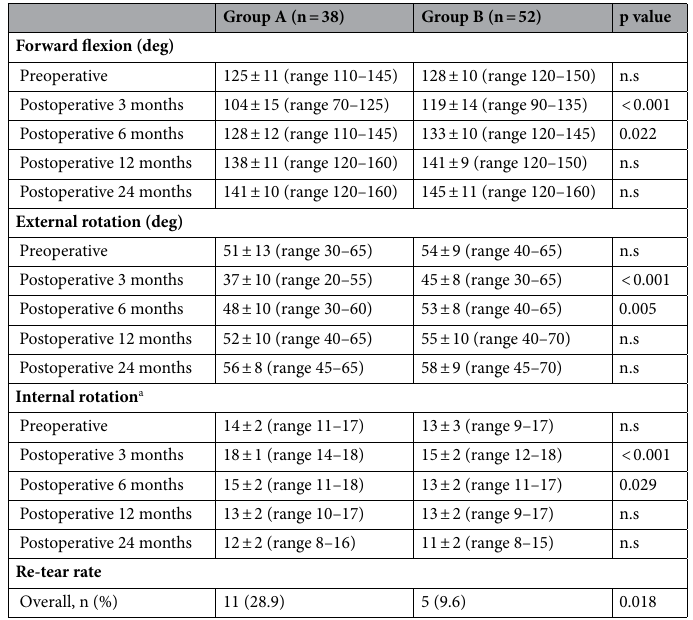
Table 3. Active range of motion and repair integrity for both groups. Values are presented as means and standard deviations. a Internal rotation was determined by measuring the highest spinal segment reached by the patient’s thumb. To facilitate statistical analyses, the spinal segment level was converted into numbers: T1 to T12 are represented as 1 through 12, L1 to L5 are represented as 13 through 17, and the sacrum is represented as